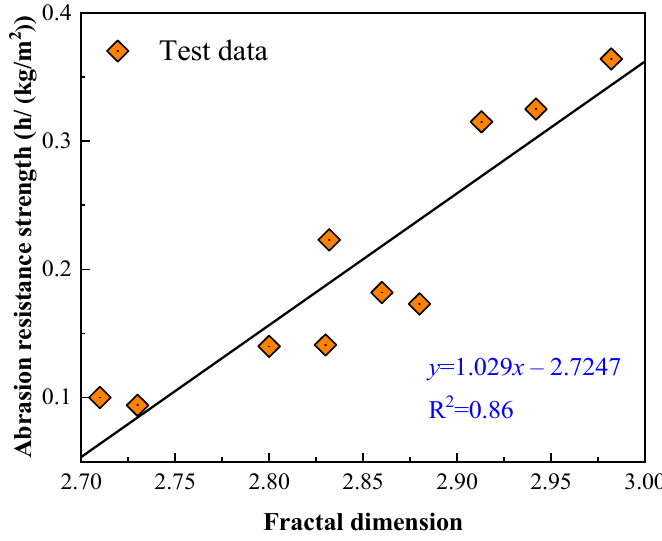
Figure 8. Relationship between fractal dimension and abrasion resistance strength of the selected sample.